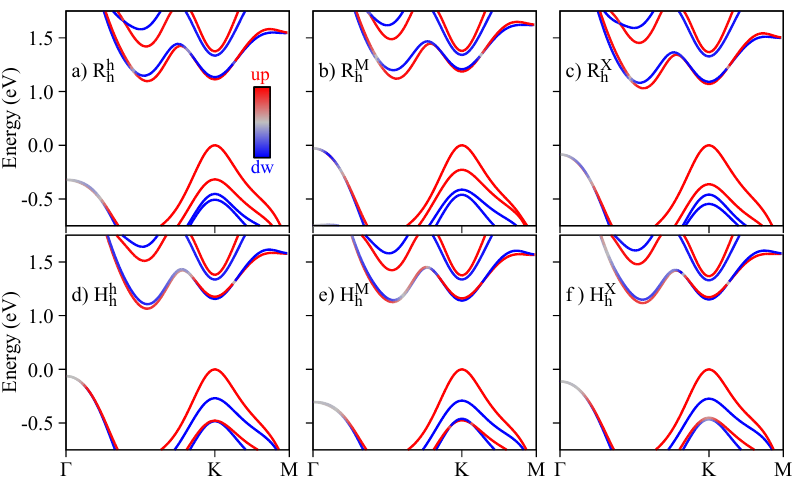
Figure 2. Spin-resolved band structures for the ( a ) R h In terms of symmetry, the R- and H-type structures considered belong to the C 3 v (P3m1) point group. In reciprocal space, the symmetry group of the Γ point is also the C 3 v group, and is reduced to its subgroups for other k -points. We find the C 3 group for the K point, the C 1 group for the Q point, and the C s group for the M point. It is